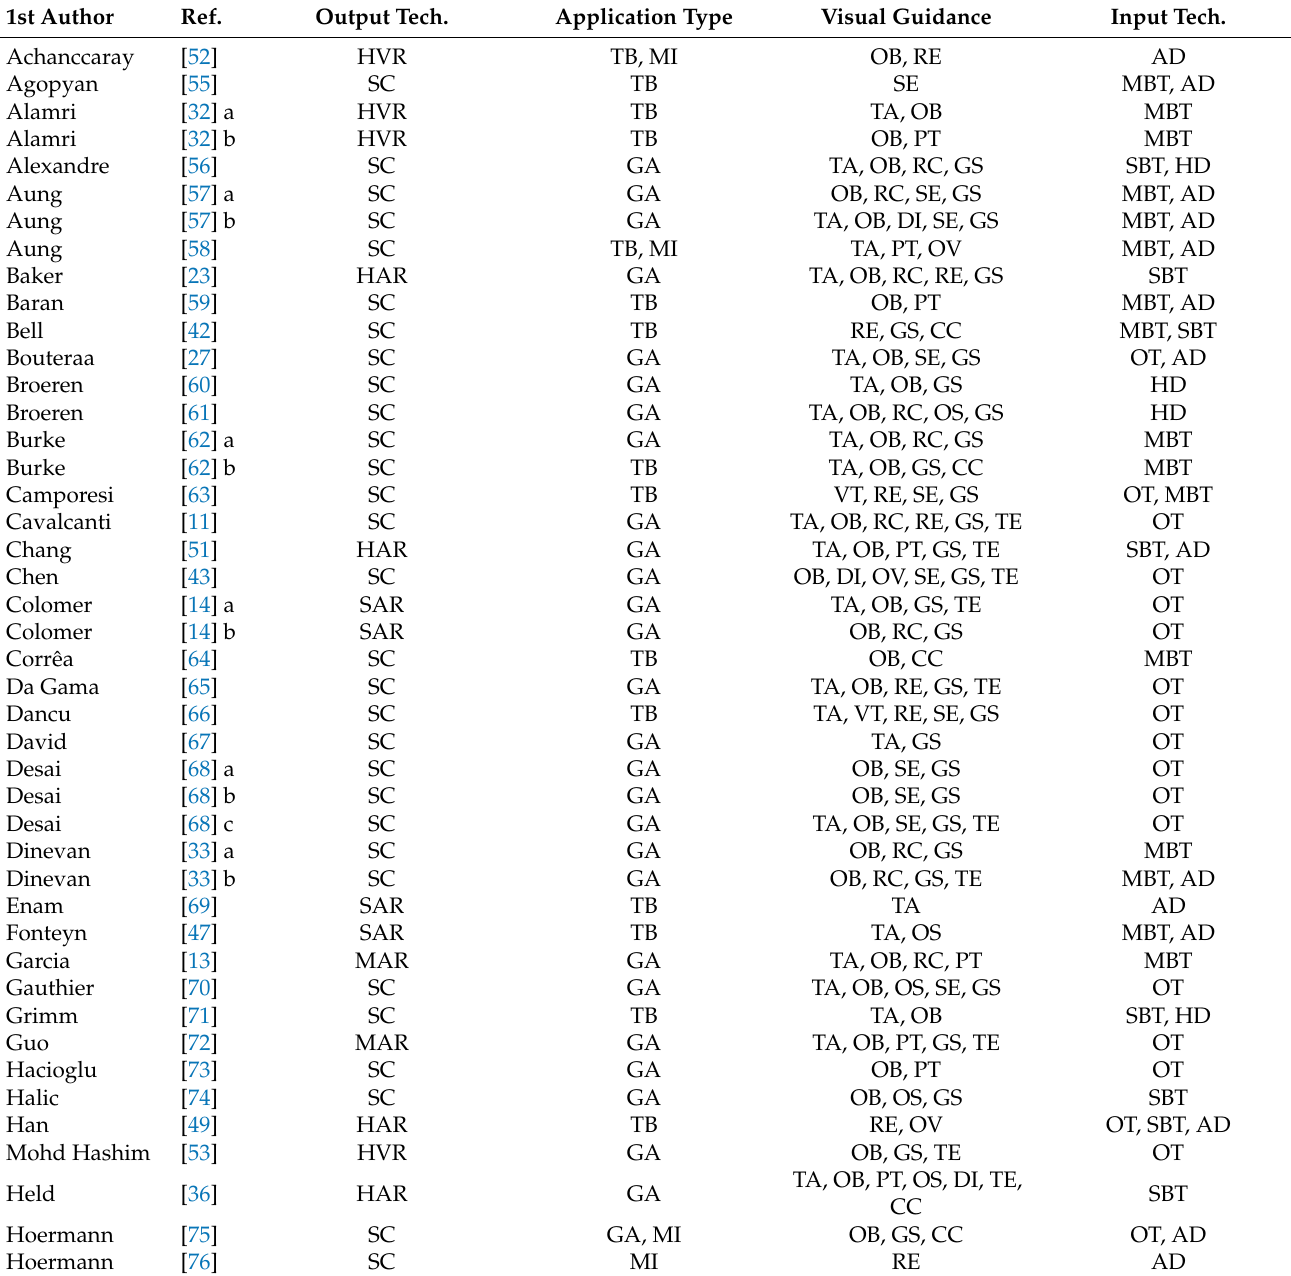
Table A2. Overview of the selected references—author names A–H, part 2/2, Abbr. in Table A7. Distinct applications within a reference are marked with lowercase